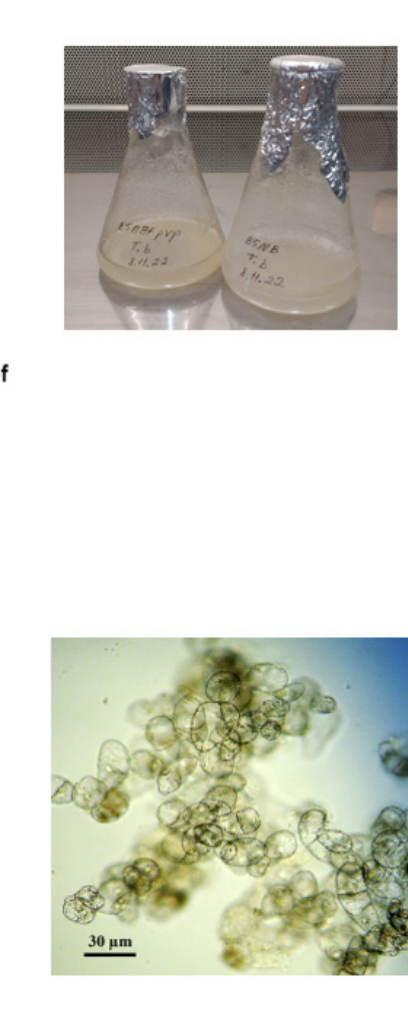
M max— maximum dry biomass accumulation, g/L. I—growth index based on dry weight. μ max — maximum specific growth rate based on dry weight, day − 1. T—doubling time, day. Y—economic coefficient. P—productivity, g/L day.